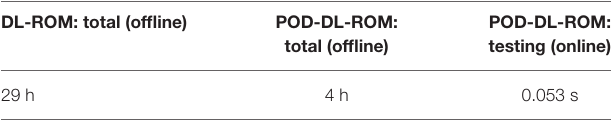
TABLE 1 | Test 1.1 : POD-DL-ROM and DL-ROM computational times. DL-ROM: total